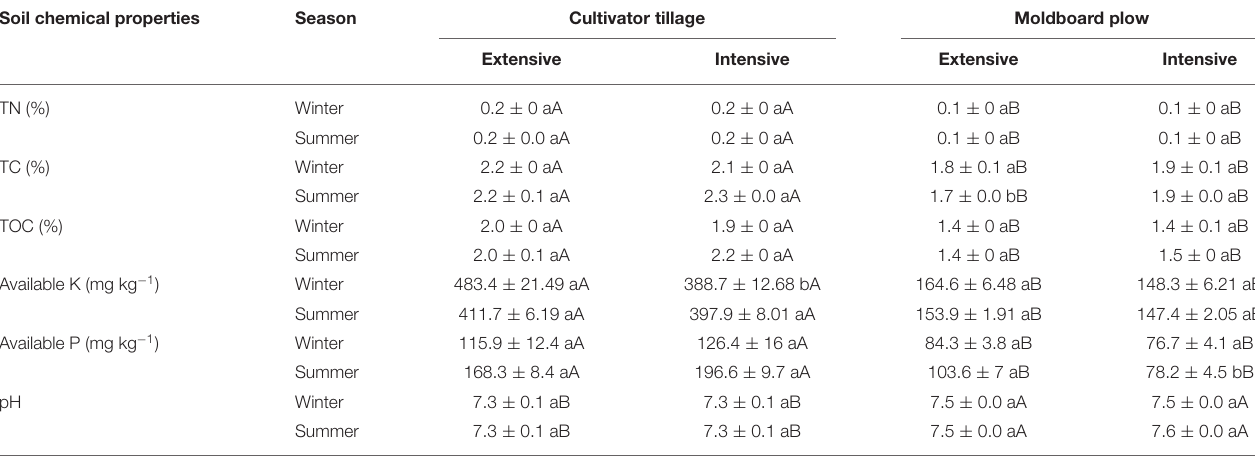
TABLE 2 | Chemical properties in soils under different long-term tillage practices (cultivator tillage vs. moldboard plow) and N-fertilization intensities (intensive vs. extensive) in LTE Bernburg. Soil chemical